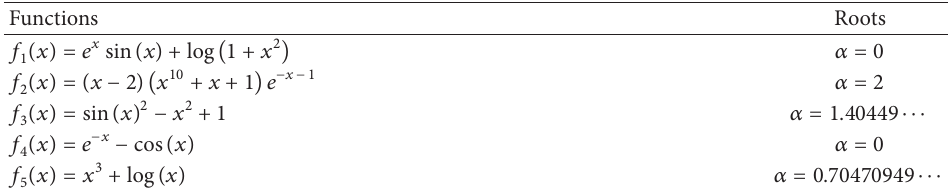
Table 1: Set of six test nonlinear functions.